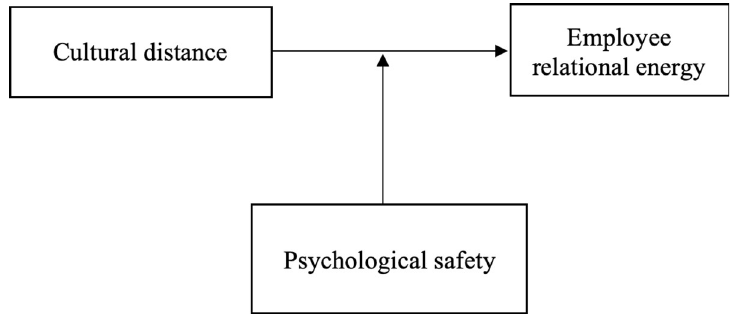
Fig 1. Conceptual model of cultural distance and employee relational